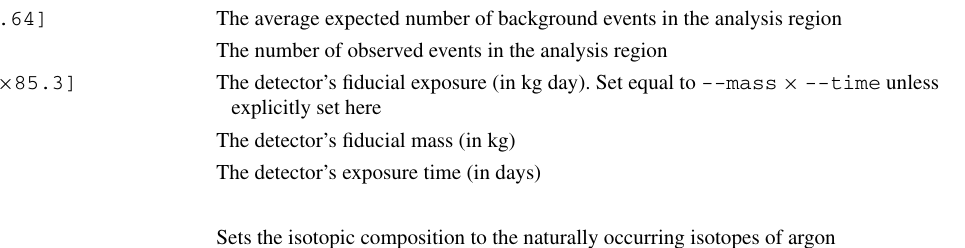
Table 6 Advanced detector options of the DDCalc default executable DDCalc_run General detector